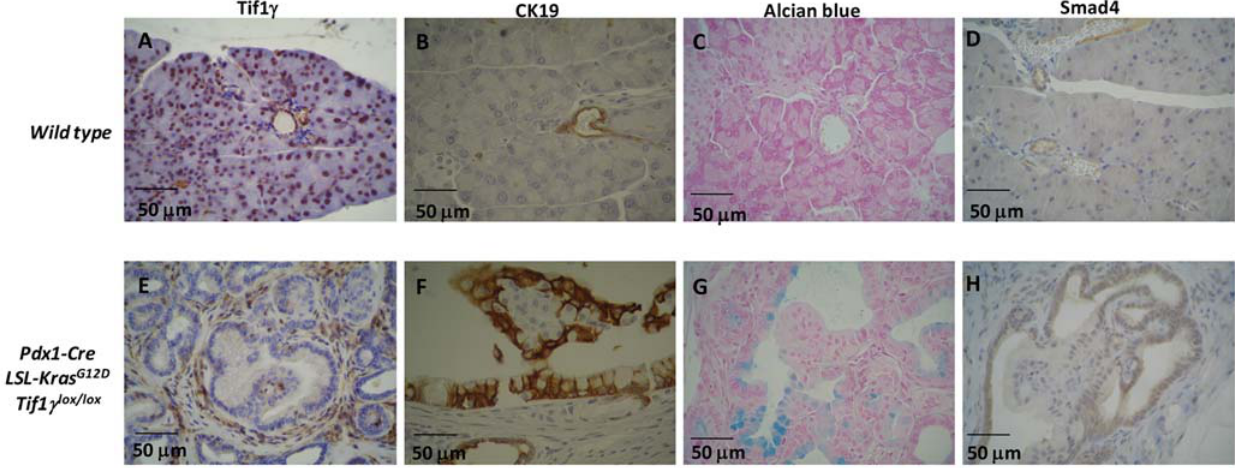
Figure 4. Immunophenotyping of pancreas cysts observed in Pdx1-Cre;LSL-Kras G12D ;Tif1 c lox/lox mice. Wild-type (A–D) and Pdx1-Cre;Tif1 c lox/lox ; LSL-Kras G12D (E–H) pancreas sections were stained to detect glandular cells (CK19), mucus-secreting cells (Alcian Blue), Tif1 c and Smad4. The pictures show one representative mouse at the age of 22 weeks.